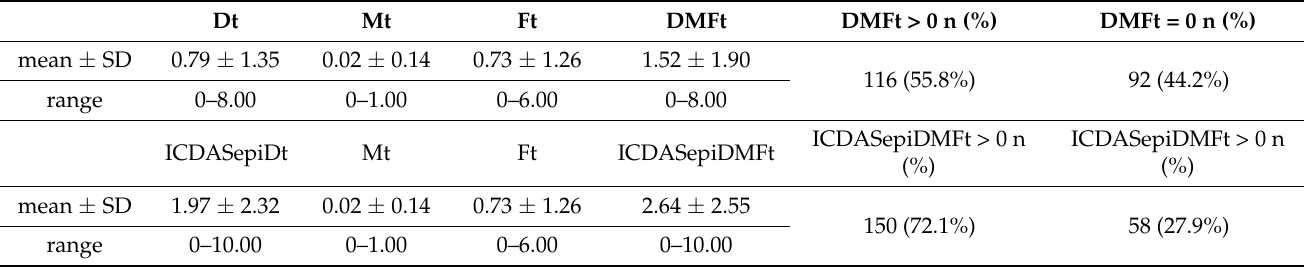
Table 4. Caries frequency, DMFt index (moderate/extensive D), ICDASepiDMFt (including initial- epiD), and its components in examined